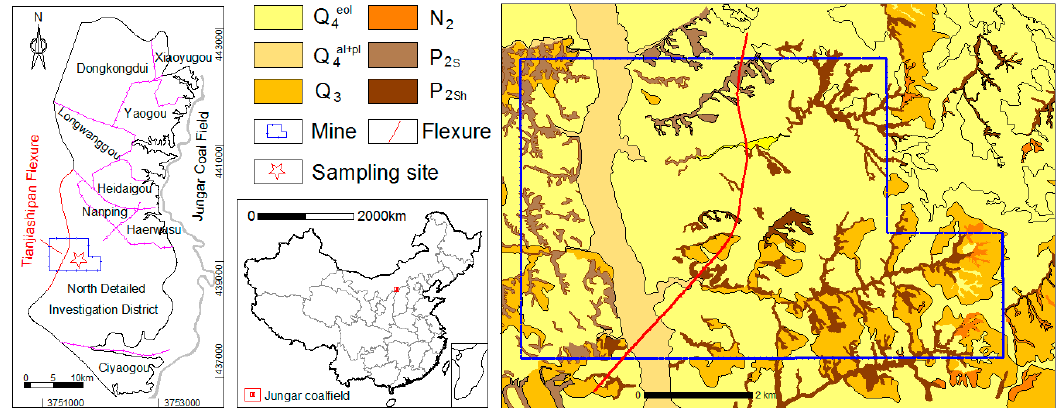
Figure 1. The Jungar coalfield mine distribution map and the Huangyuchuan mine geology map.